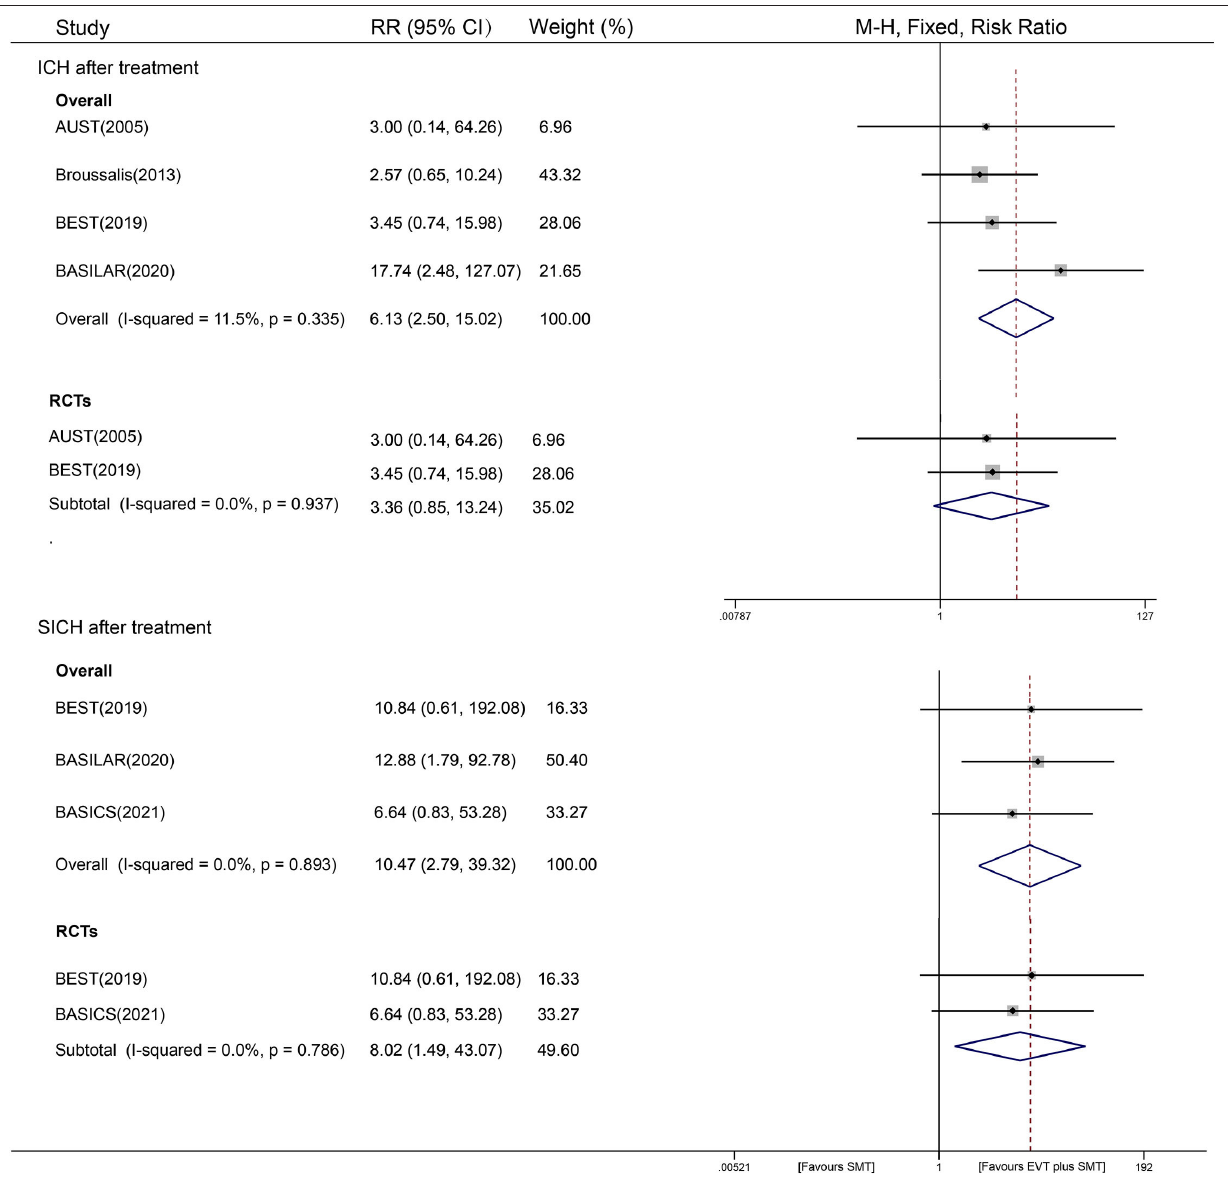
Frontiers in Neurology |